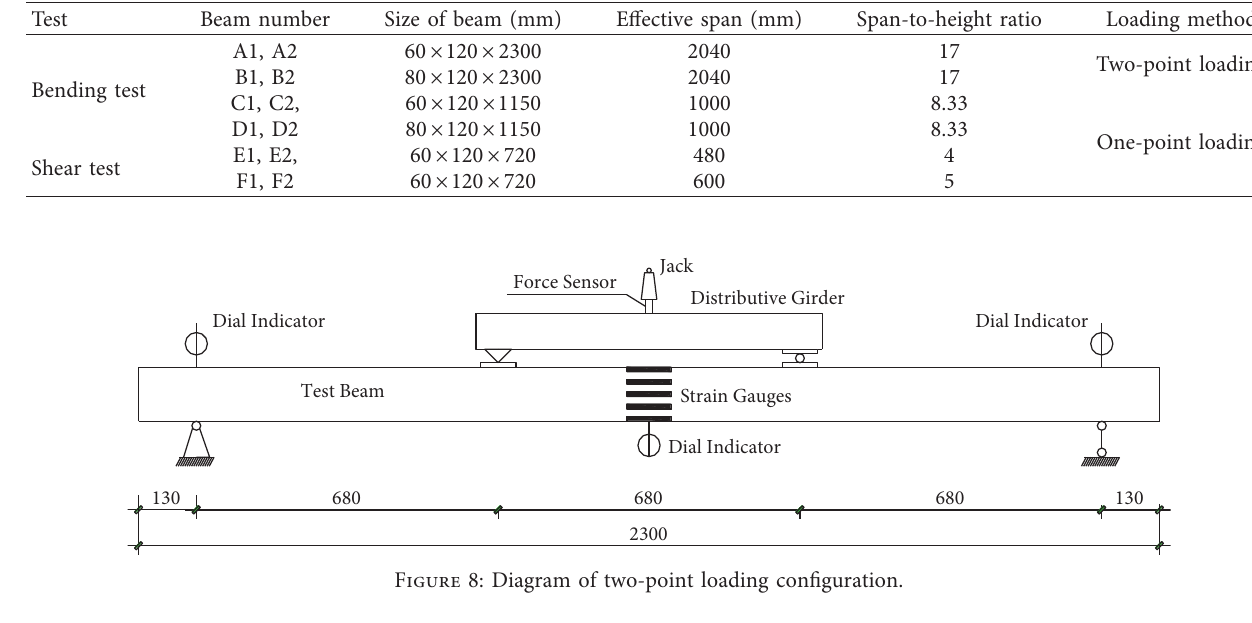
Table 4: Size of full-sized beams.